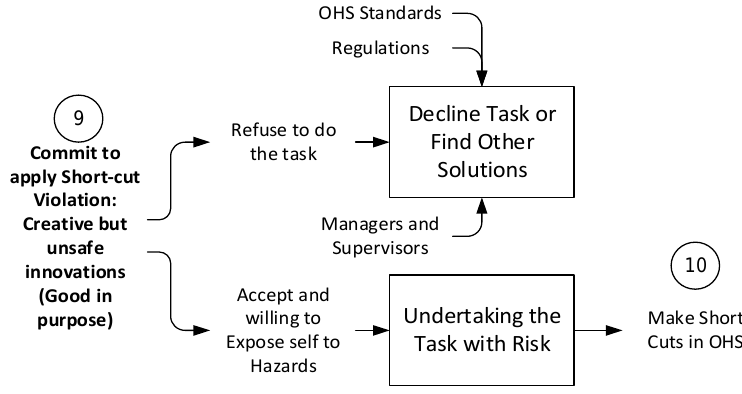
Figure 9. Worker executes the Task Process.